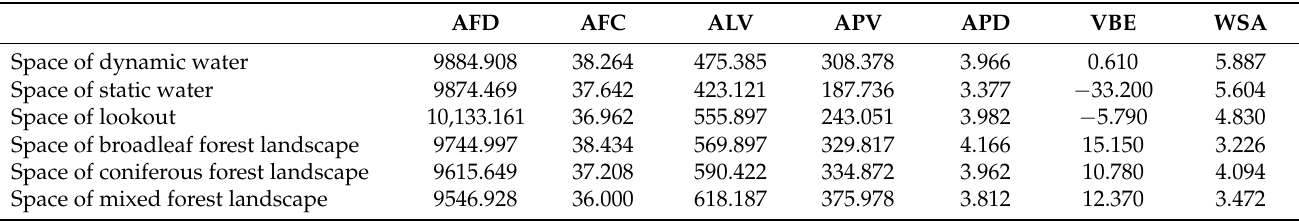
Table 4. Participants’ visual behavior and satisfaction preference in forest recreation landscape space.